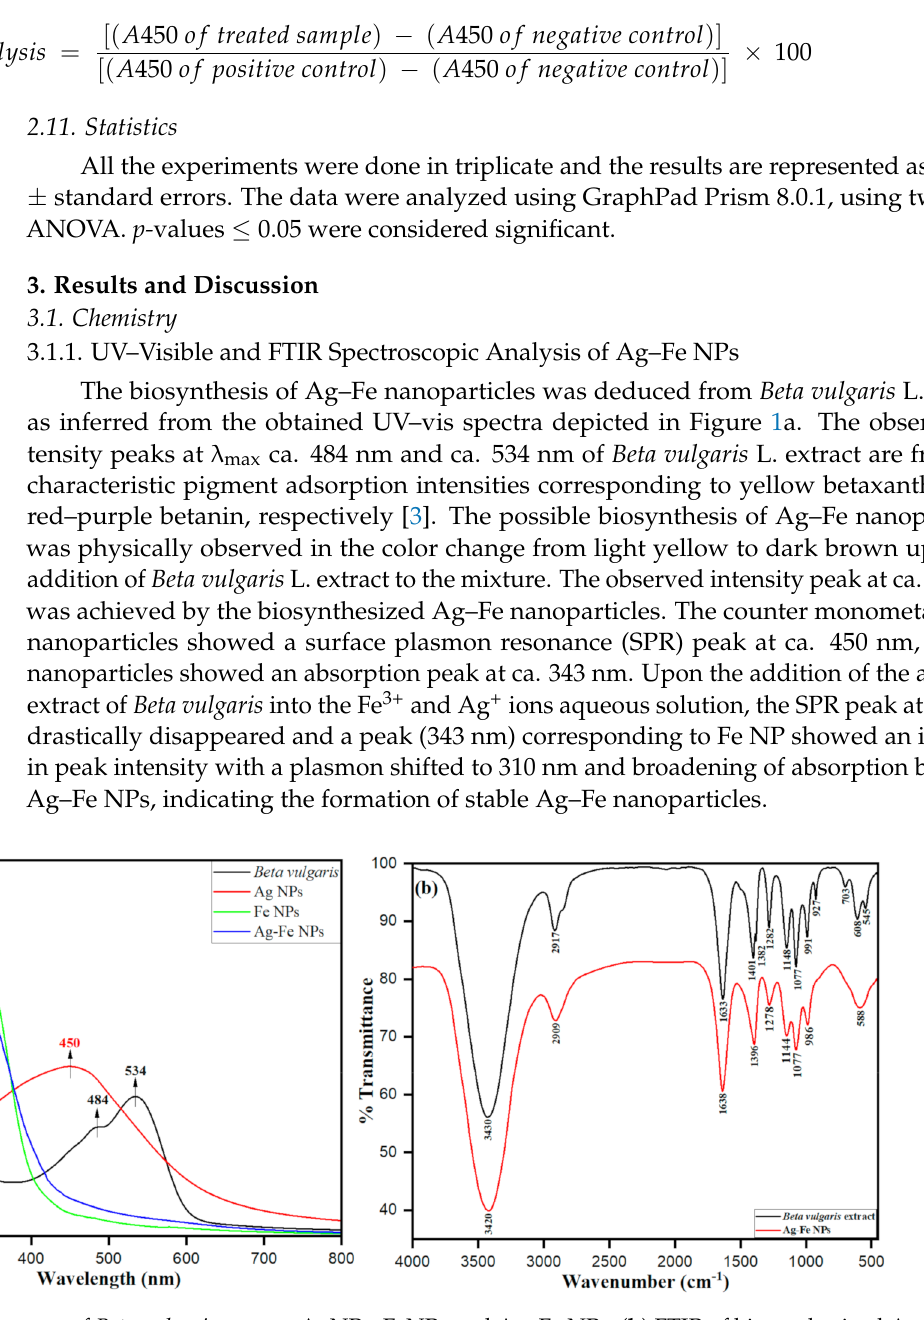
Figure 1. ( a ) UV–visible spectra of Beta vulgaris extract, AgNPs, FeNPs and Ag–Fe NPs; ( b ) FTIR of biosynthesized Ag–Fe bimetallic nanoparticles from Beta vulgaris L.